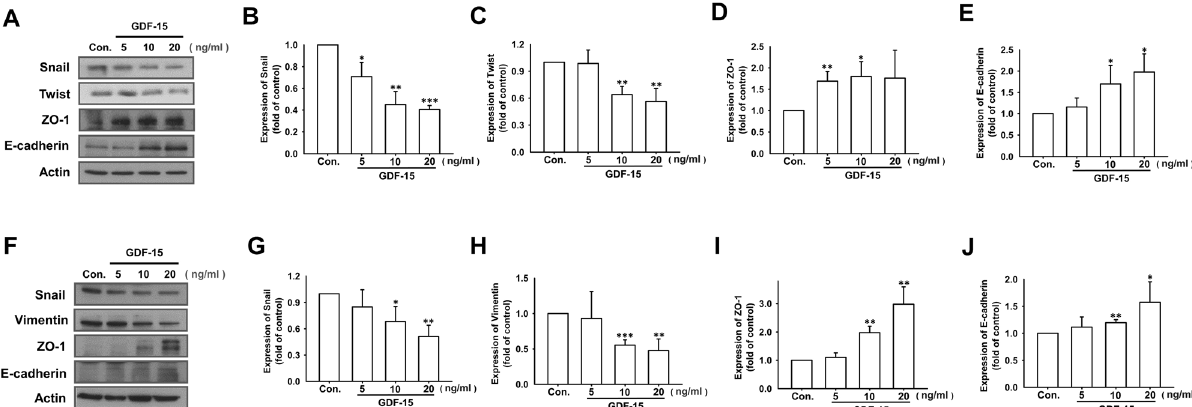
Fig. 7 GDF-15 reverses epithelial-mesenchymal transition by increasing epithelial markers expression and decreasing mesenchymal markers expression in breast cancer cell lines. 4T1 cells were treated with murine recombinant GDF-15 protein (5 to 20 ng/ml), and MDA-MB- 231 cells were treated with human recombinant GDF-15 protein (5 to 20 ng/ml). After treating with GDF-15 recombinant protein for 24 h, protein expression of epithelial/mesenchymal markers were detected by Western blot. It is shown that recombinant GDF-15 decreased the expression of mesenchymal markers (Snail, Twist and vimentin) but increased the expression of epithelial markers (E-cadherin and ZO-1) on 4T1 (A – E) and MDA-MB-231 (F – J) breast cancer cells. Graphs showed mean ± S.D. of three independent experiments. p value was calculated